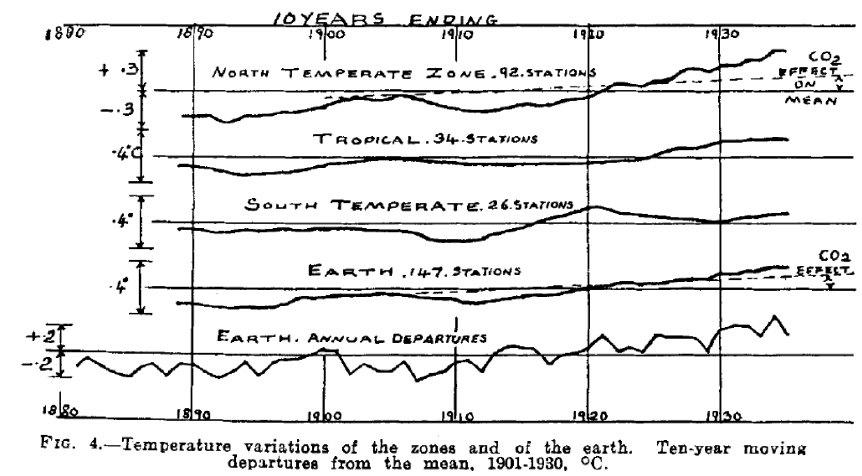
Figure 1. Graph taken from Callendar (1938). The fourth curve represents his GMST series, based on temperature data of 147 stations. To highlight smooth changes over time he used moving averages with a window of 10 years. It is interesting to note that he also addressed the specific effect of CO 2 emissions on global temperatures (dashed